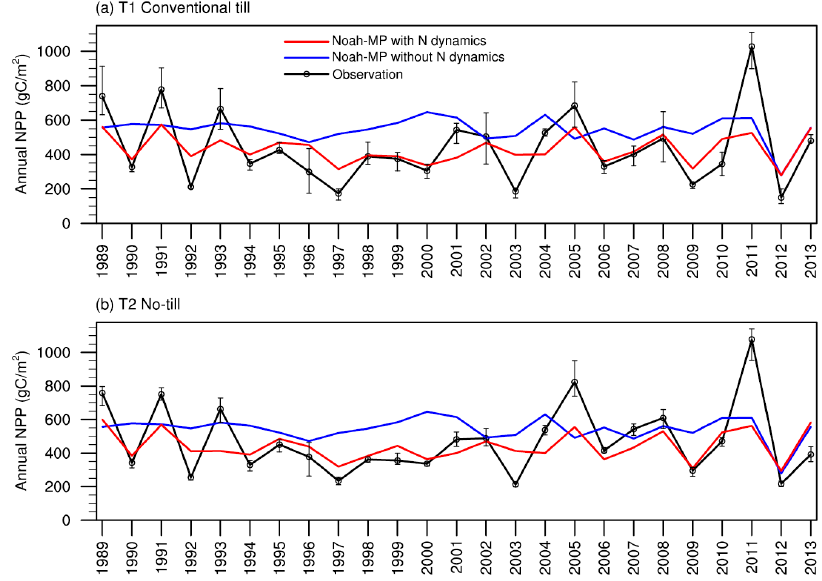
Figure 5. Observed and modeled annual NPP from 1989 to 2013 for (a) treatment 1 – cropland with conventional tillage – and (b) treatment 2: cropland without tillage. The error bars show the observational ranges from up to six replicates for each